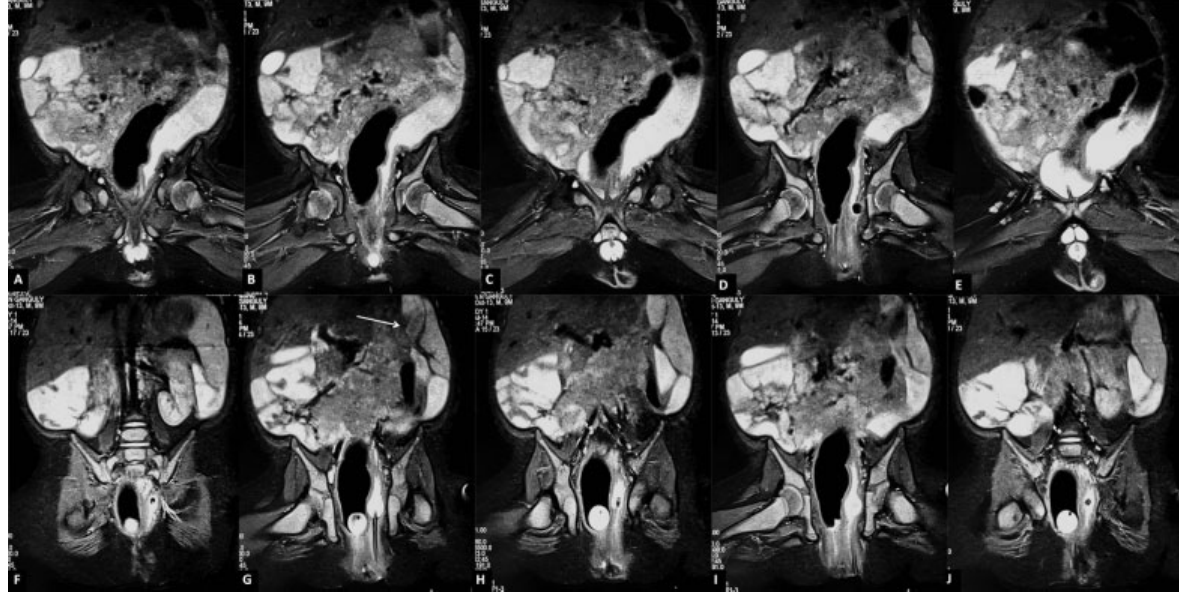
Fig. 2 Serial coronal T2-weighted magnetic resonance images (from a three-dimensional stack) from anterior to posterior (A – J) performed with differential contrast technique shows the two moieties ofduplicated descending colon, the medial moiety was insuf fl ated with air whilethe lateral was fi lled with saline. Note the point of union at the splenic fl exure (straight arrow in G). Note the clear separation of the wall of both the moieties with a clear cut plane between the